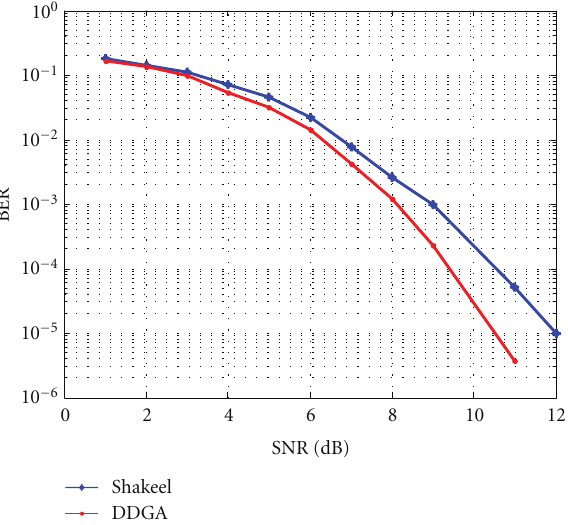
Figure 29: Performances of DDGA, and Shakeel algorithms for BCH (63,45,7) code over